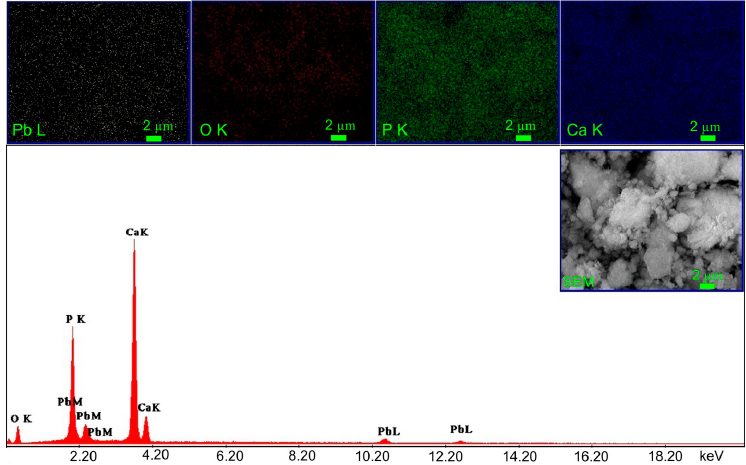
Figure 13. EDX spectrum and elemental mapping of CD-HAp_2 sample after the adsorption of Pb 2+ .